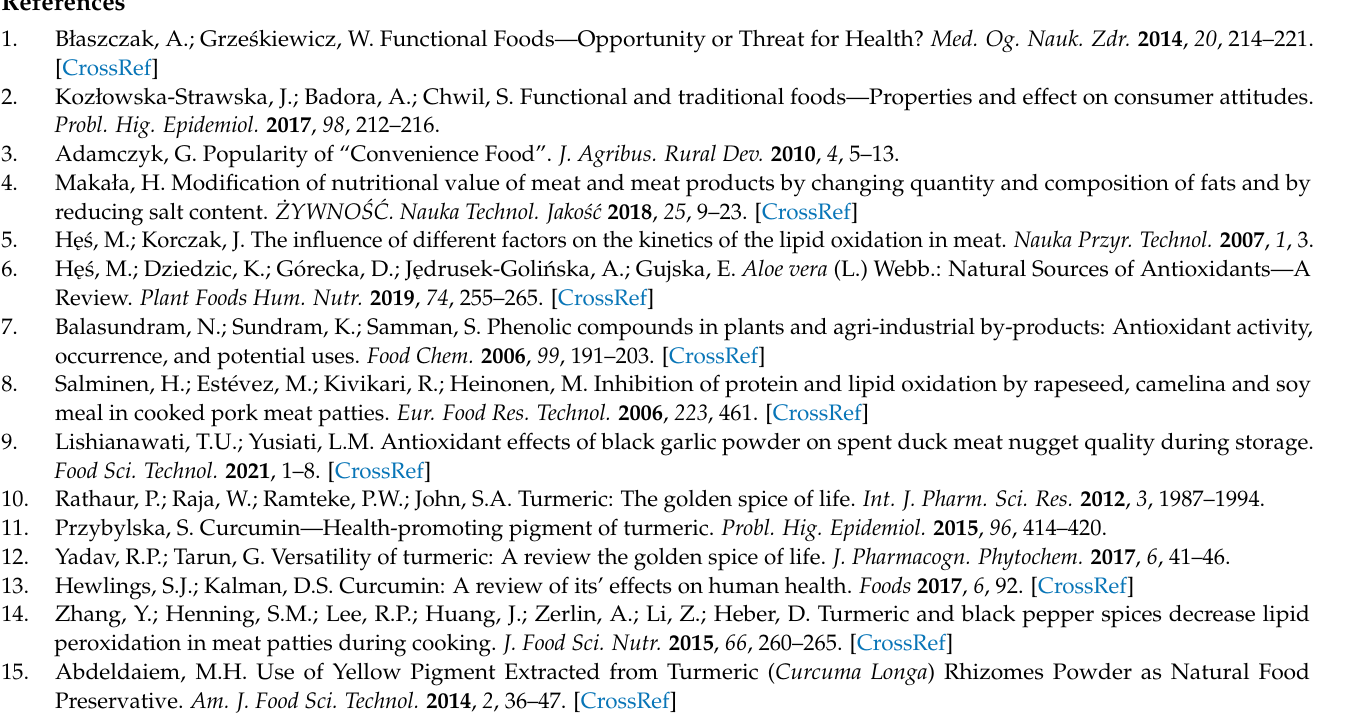
group (group I) during refrigerated storage (means ± standard error of means and F and p statistics (ANOVA), Figure S2: TBARS value (mg MDA/kg) in duck burgers in group II (with turmeric powder) during refrigerated storage (means ± standard error of means and F and p statistics (ANOVA), Figure S3: TBARS value (mg MDA/kg) in duck burgers in group III (with turmeric extract) during refrigerated storage (means ± standard error of means and F and p statistics (ANOVA), Figure S4: TBARS value (mg MDA/kg) in duck burgers in group IV (with turmeric paste) during refrigerated storage (means ± standard error of means and F and p statistics